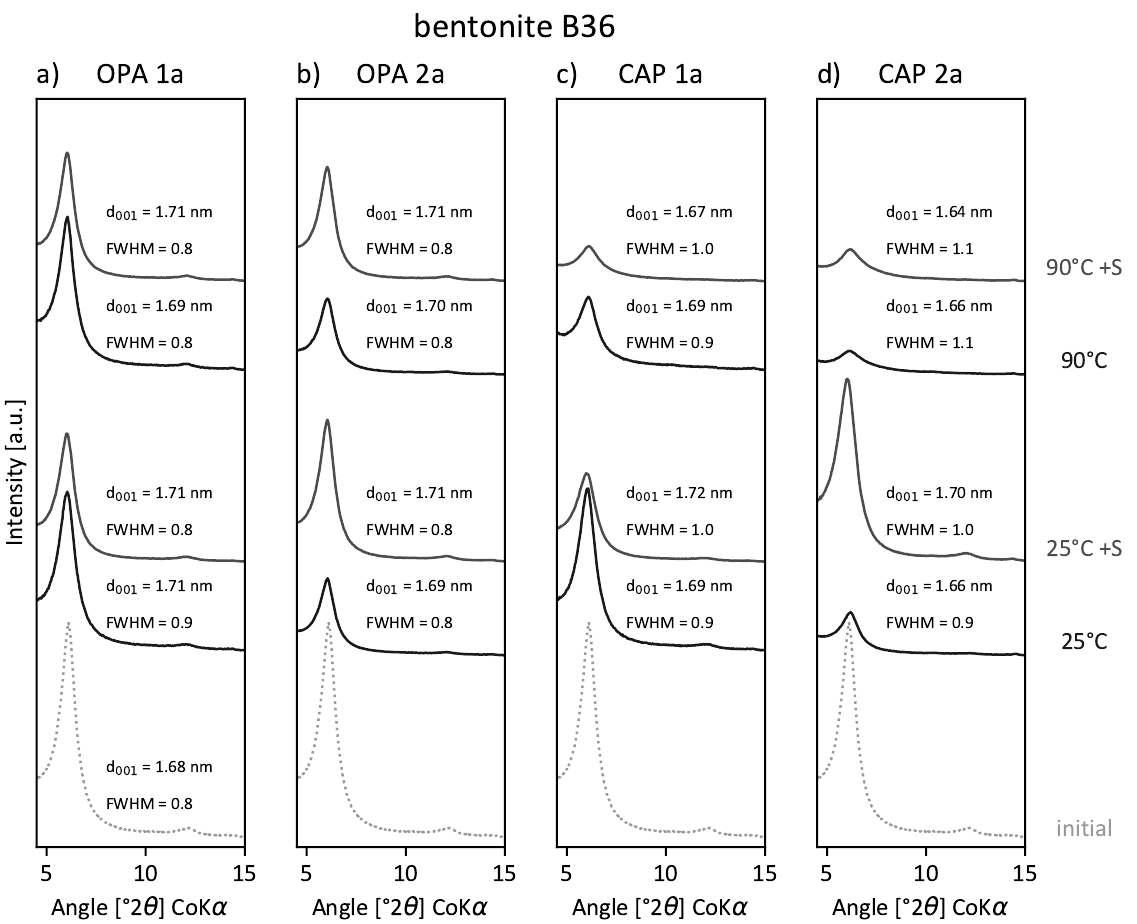
Figure 6. XRD patterns (oriented slides of purified smectite; ethylene glycol-saturated) of the initial B36 bentonite and reacted samples at two different temperatures (25 and 90 ◦ C) with substrate (+S) and controls. ( a , b ) OPA solution for 1 and 2 years and ( c , d ) CAP solution for 1 and 2 years. Samples reacted in CAP solution show a continuous decrease of d (001) in combination with an increase of FWHM (in ∆ ◦ 2 θ ) with higher temperature and duration. OPA: Opalinus clay pore water, CAP: diluted cap rock